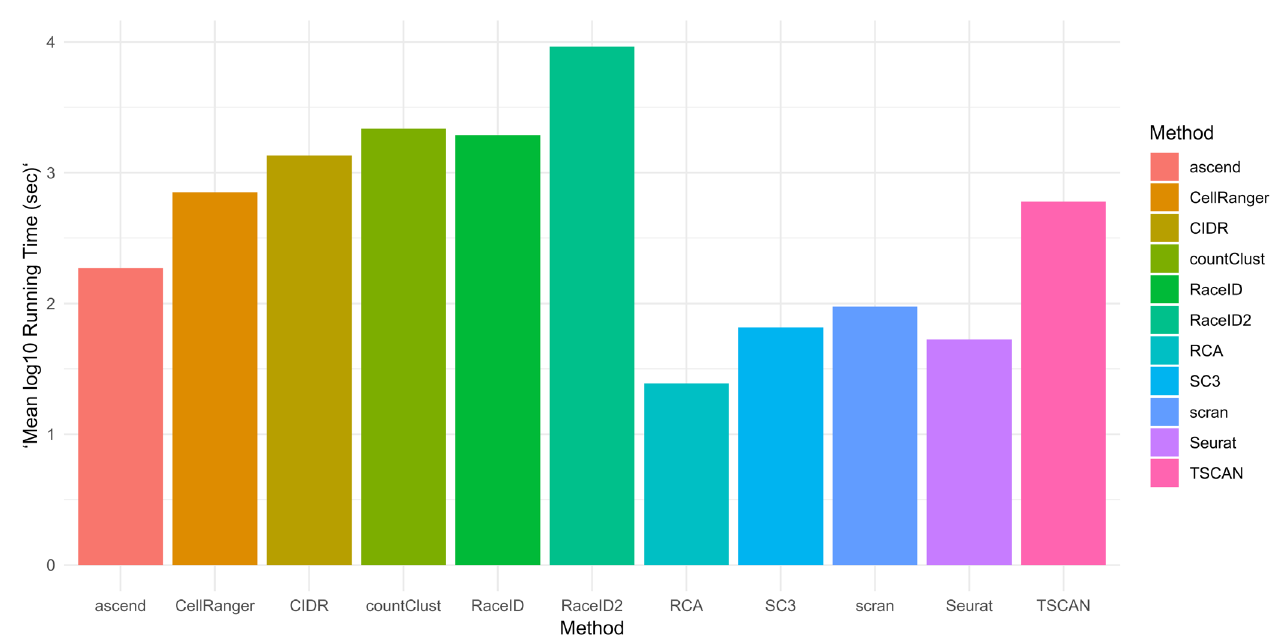
Figure 7. The bars indicate the average log10 run time (in seconds) of all 11 methods on Dataset 5 with 3,000 genes over 5 iterations.